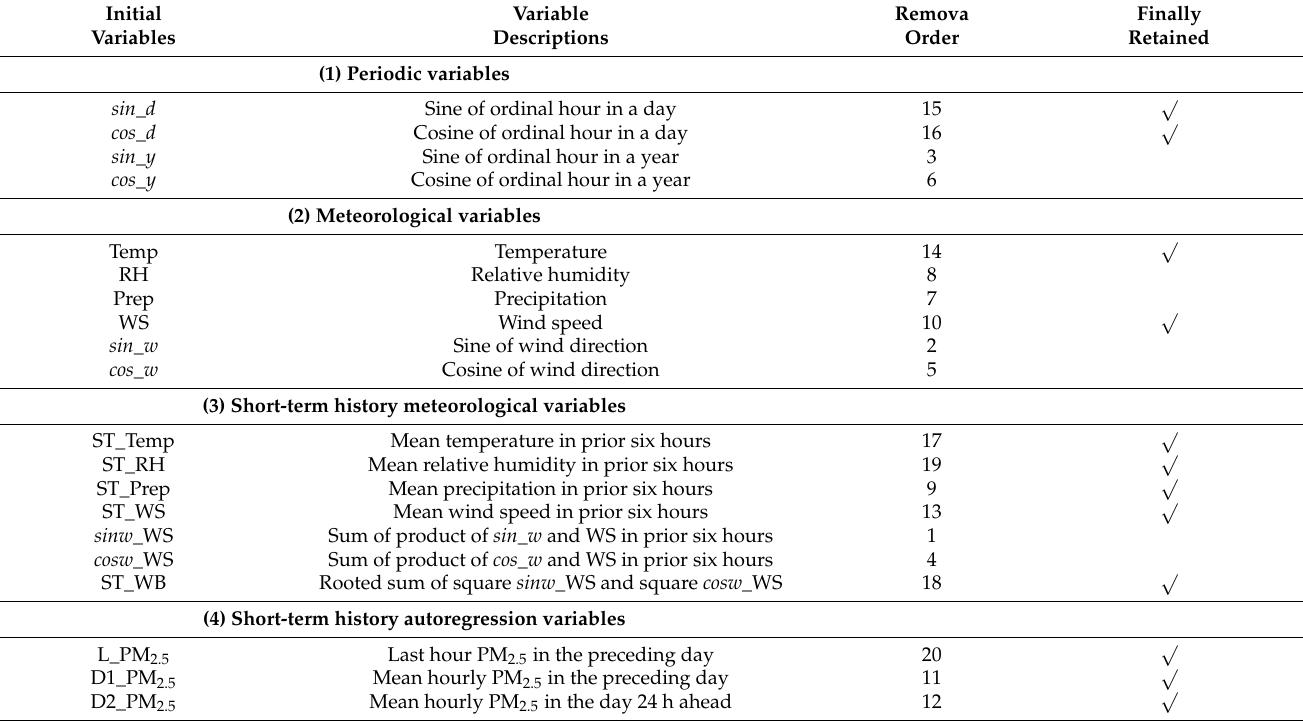
Table 2. Initial feature variables and their removal order in the spiral validation